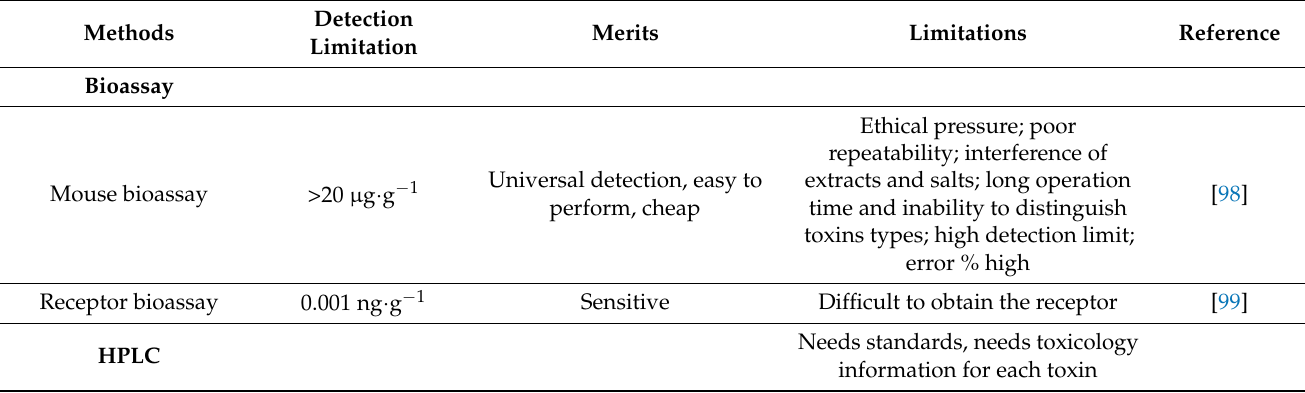
Table 3. Characteristics of main DA detection